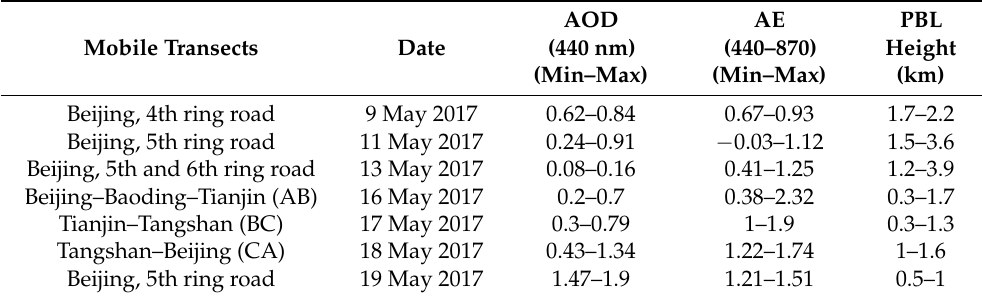
Figure 2. Spatial variability of AOD at 440 nm (top panels ( a – f )) and Angstrom Exponent (AE) between 440 and 870 nm (bottom panels ( g – l )), derived from PLASMA sun photometer measurements. The A, B and C ( d , k ) denote the departure and end points for the three transects: Beijing–Tianjin (AB) on 16 May 2017, Tianjin–Tangshan (BC) on 17 May 2017 and Tangshan–Beijing (CA) on 18 May 2017. Please note that the color scale for the AOD maps is different for each transect in order to show the fine spatial variability. Table 2. Summary of mobile transects and aerosol properties observed during MOABAI campaign: AOD at 440 nm and Angstrom Exponent (AE) measured by the PLASMA sun photometer and PBL height derived from LIDAR